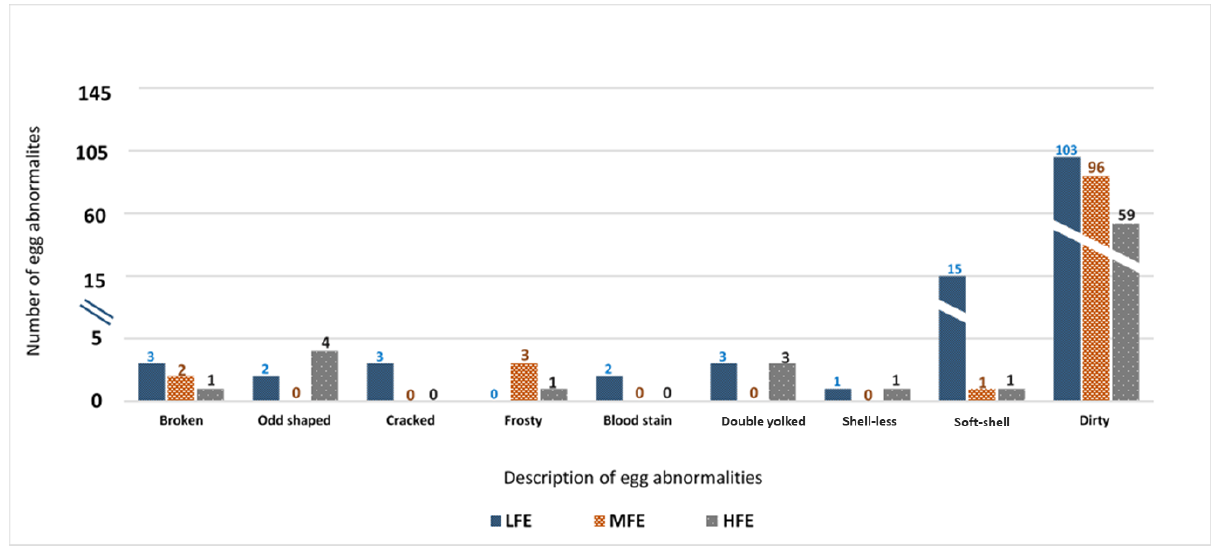
Figure 3. The breakdown of abnormalities in eggs from individual ISA Brown hens of varying feed efficiencies in the mid-laying stage aged between 35–40 weeks ( n = 48 per high, medium, and low FE groups). HFE: High feed efficiency; MFE: Medium feed efficiency; LFE: Low feed efficiency. A total of 70 abnormal eggs were collected from the HFE group for the entire experimental period, while a total of 94 and 126 were collected from the MFE and LFE groups, respectively, for the 42-day experimental period.